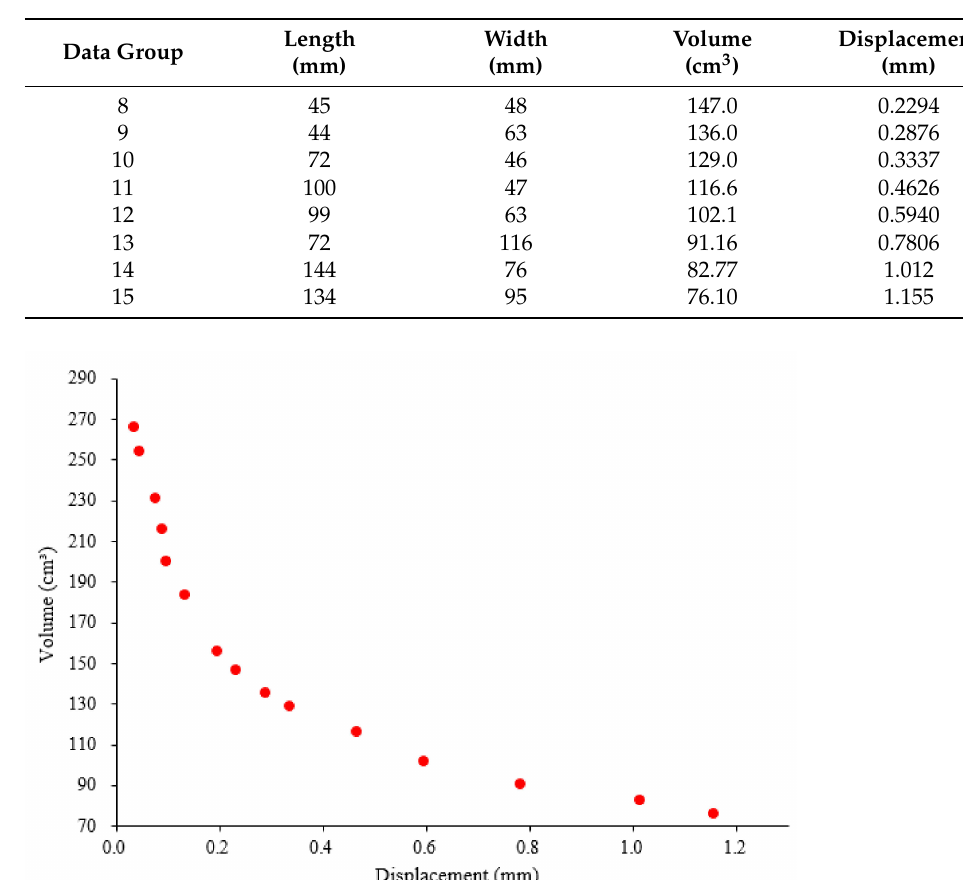
Figure 9. W-type optimization analysis results based on the